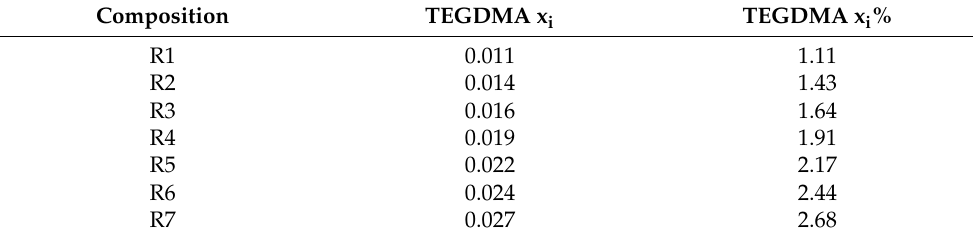
Table 1. Composition changes in TEGDMA are expressed as the molar-weight fraction and molar- weight percentage of the entire volume. TEGDMA changes here from 1.11% of the system to 2.68% of the system throughout these compositions. The only change between NMIP and MIP samples is the addition of Timolol (x i =